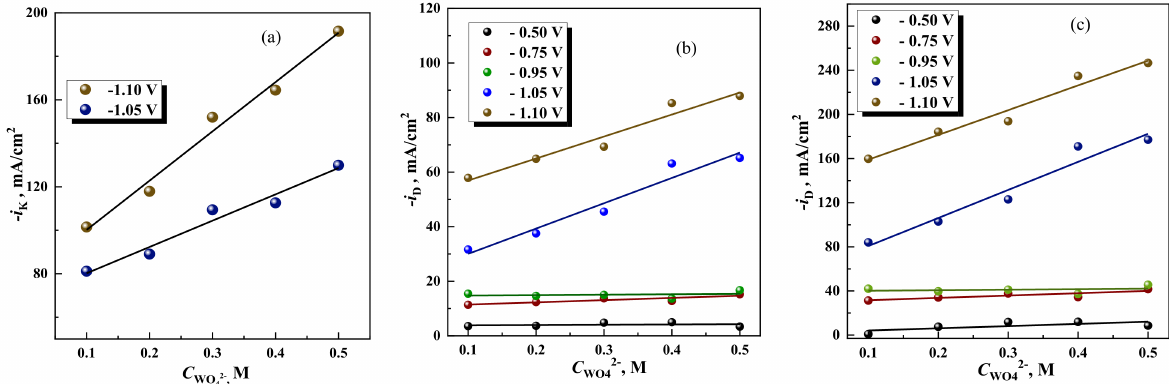
Figure 7. The effect of Na 2 WO 4 concentration on kinetic current densities ( a ), and diffusion current densities for 200 rpm ( b ); 1500 rpm ( c ).